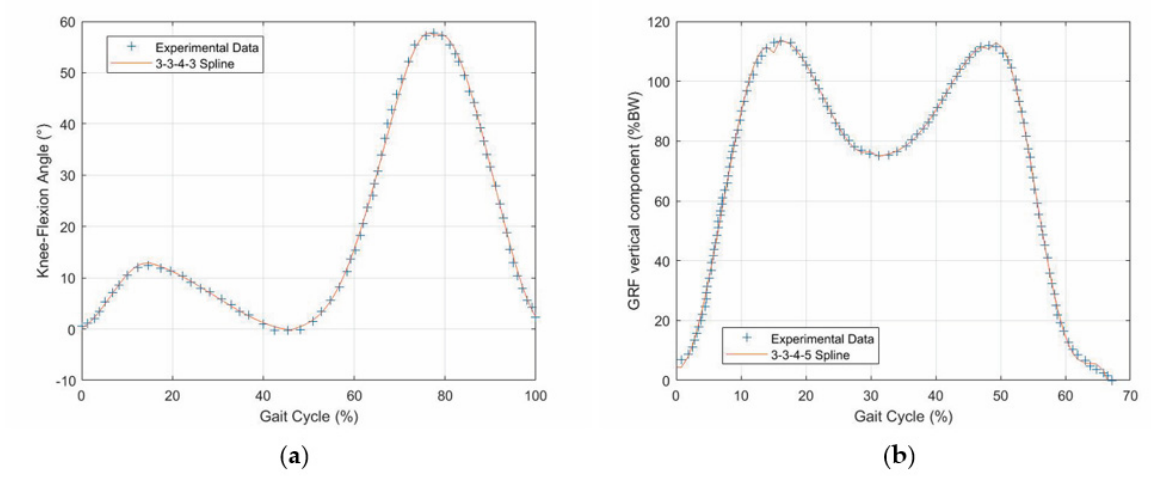
Figure 4. Curve fitting: ( a ) knee-flexion angle and ( b ) GRF vertical component.